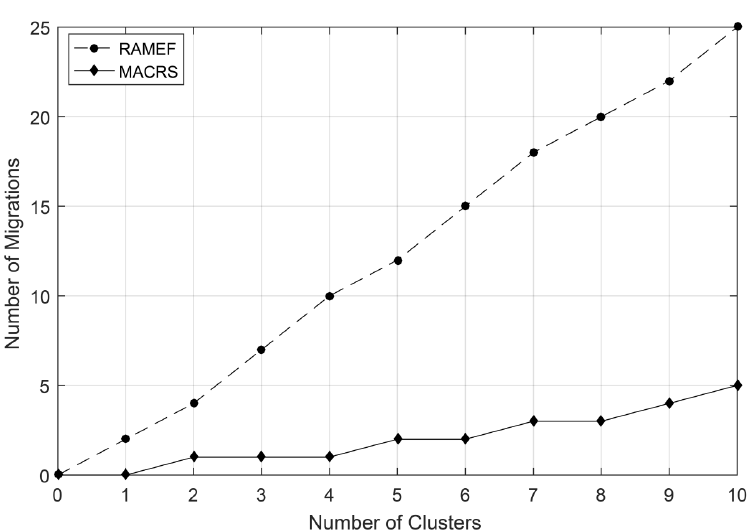
Figure 9. Number of migrations for a single node.